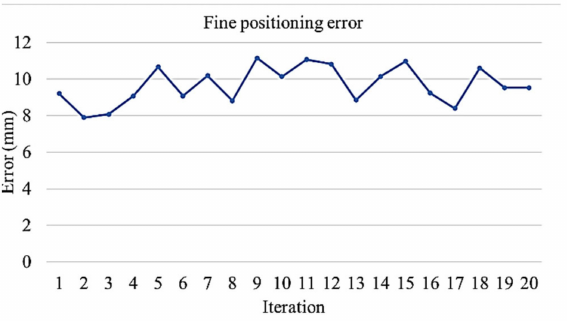
Figure 8. Positioning error measured using the robot’s fine positioning feature in 20 repeat experiments.